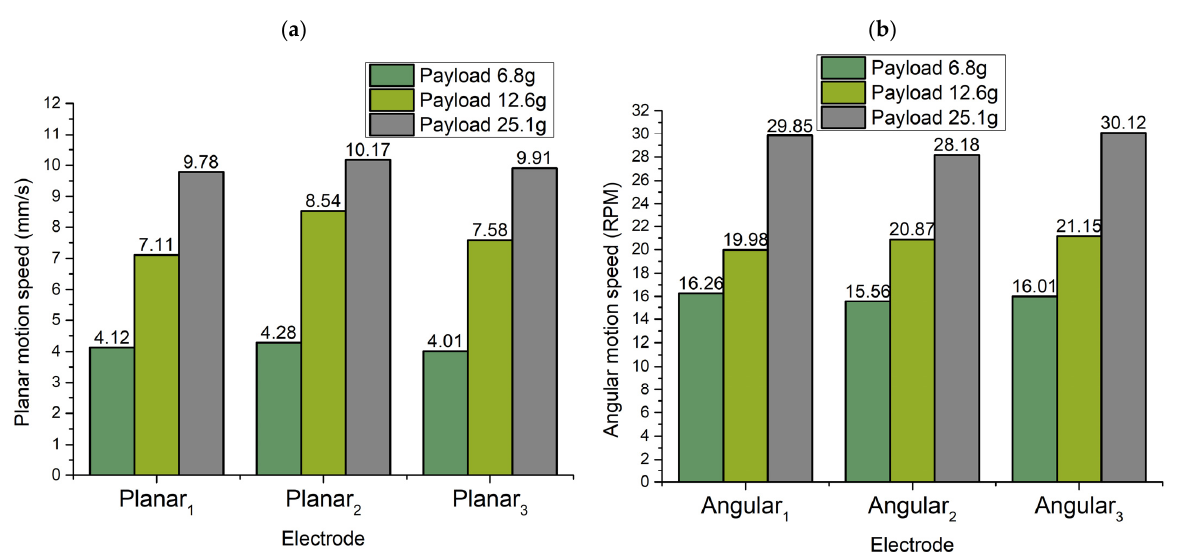
Figure 19. Summary of minimum and maximum angular speed while different payloads are applied to the robot: ( a )—summary of minimal angular speed; ( b )—summary of maximum angular speeds.